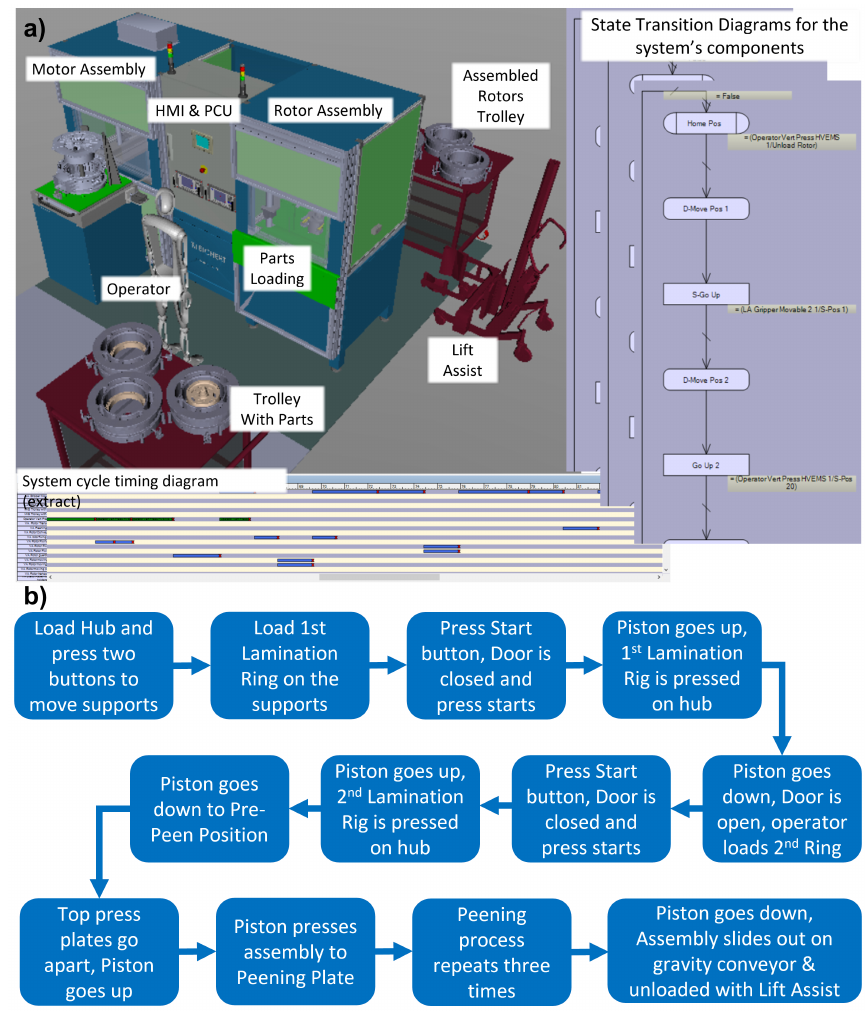
Figure 5. ( a ) Vertical assembly station final layout ( b ) The corresponding process